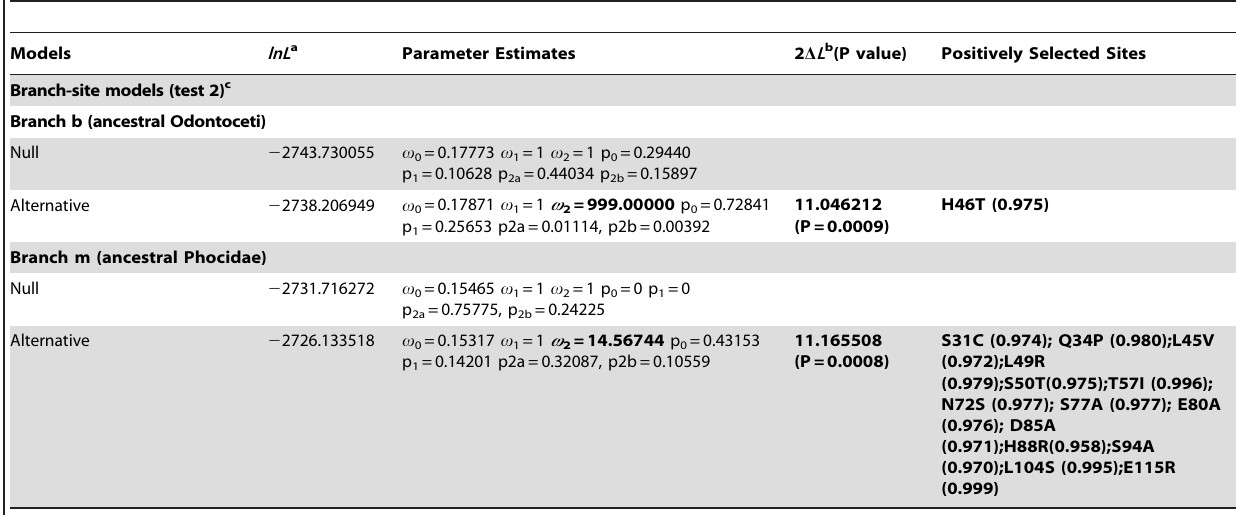
Table 1. PAML analyses for leptin gene and evidence of positive selection for Odontoceti and Phocidae.